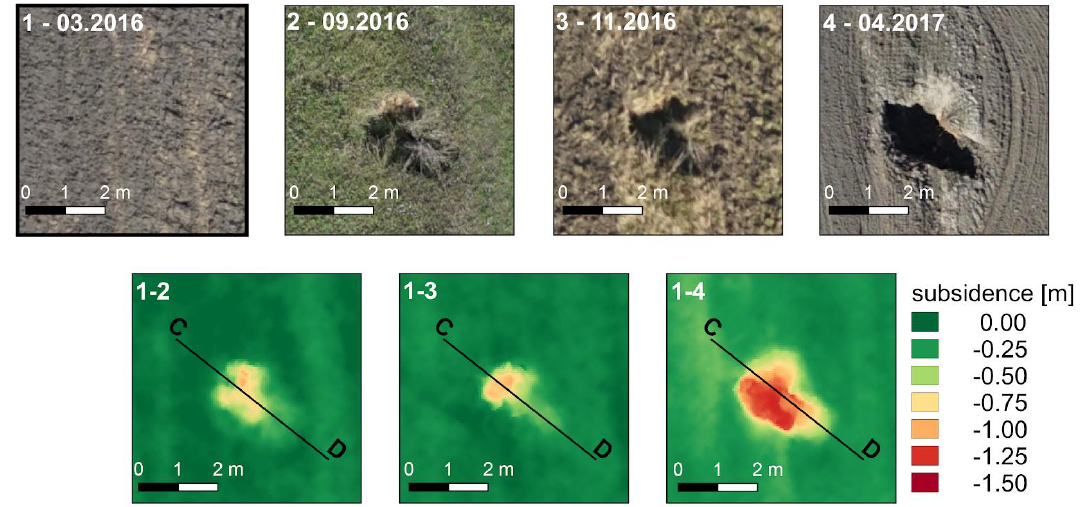
Figure 9. Development of a C–D discontinuous deformation (Piekary site).